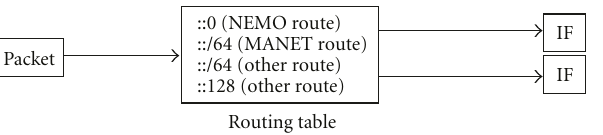
Figure 5: Classic routing. A single routing table is used, and packets are forwarded along the route with the longest matching prefix.